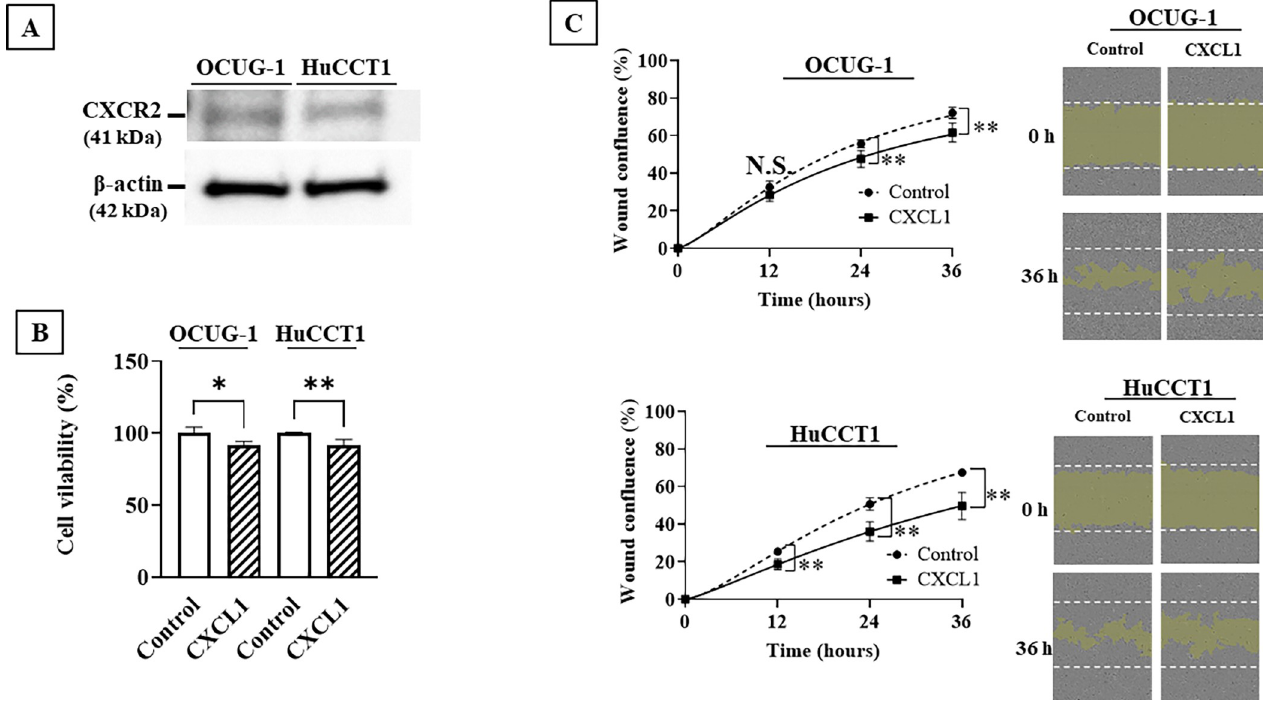
Fig 1. Effect of CXCL1 on the proliferation and migration of CCA cells. A, CXCR2 expression on OCUG-1 cells and HuCCT1 cells. B, CXCL1 significantly inhibited the proliferative potential of OCUG-1 cells and HuCCT1 cells at 72 h. �� , p < 0.01 vs control. C, CXCL1 significantly inhibited the migration potential of OCUG-1 cells after 24 h and HuCCT1 cells after 12 h. �� , p < 0.01 vs control. CXCR2-negative patients (n = 132) (p = 0.031) ( Fig 3B ). Patients with both CXCL1- and